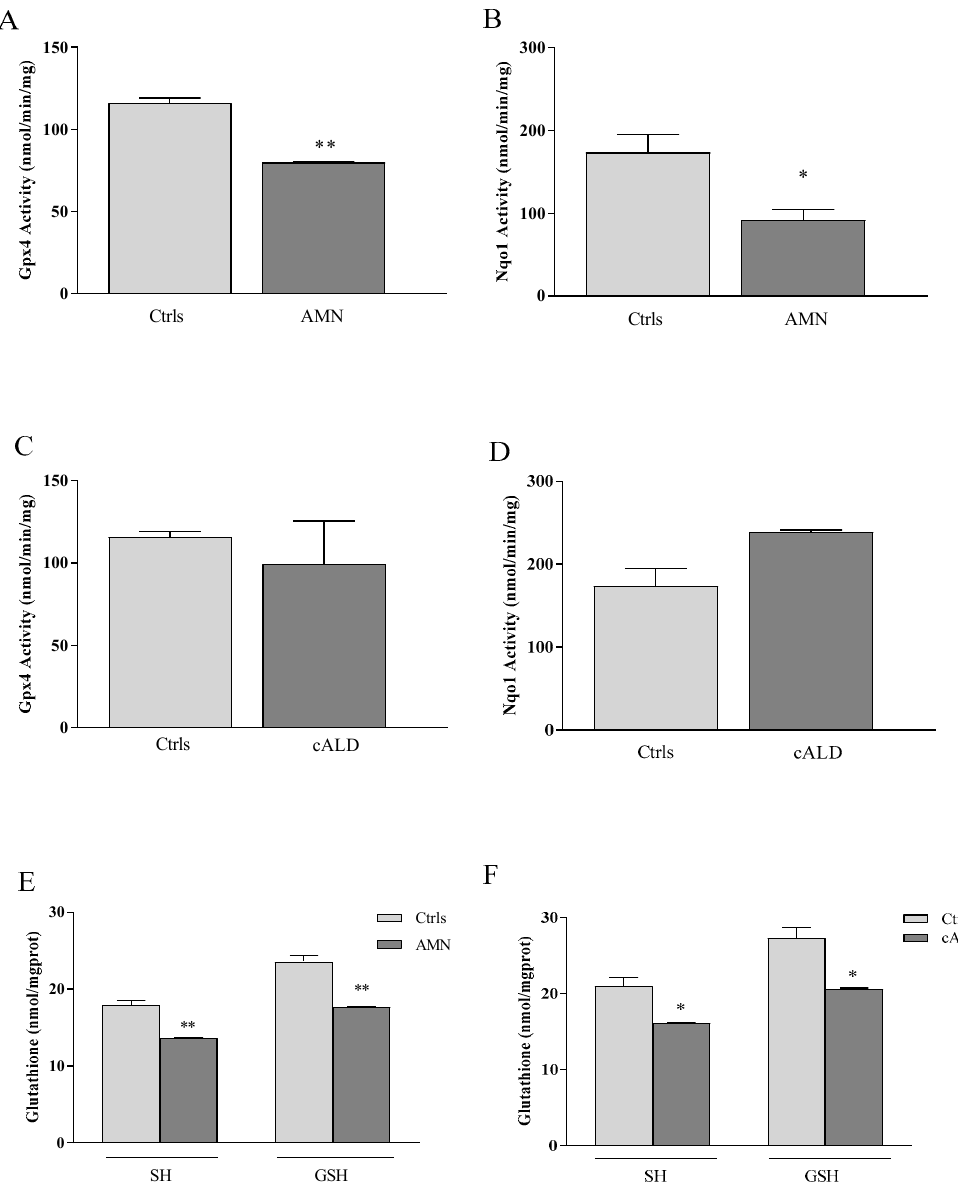
Figure 2. ( A , C ) Gpx4 and ( B , D ) Nqo1 enzyme activities. ( E , F ) Thiols and glutathione (GSH) content. Experiments were performed in triplicates and values expressed as mean ± SD. * p < 0.05, ** p < 0.01, compared to controls (by Student’s two-tailed t